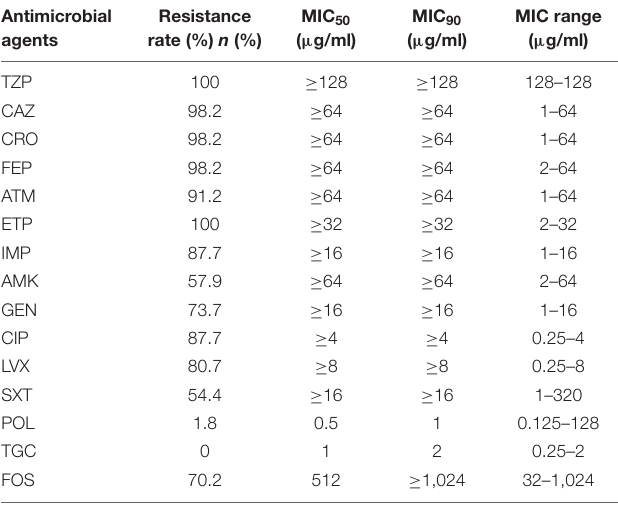
TABLE 1 | Antimicrobial resistance profile of the CRKP strains. Antimicrobial Resistance agents rate (%) n